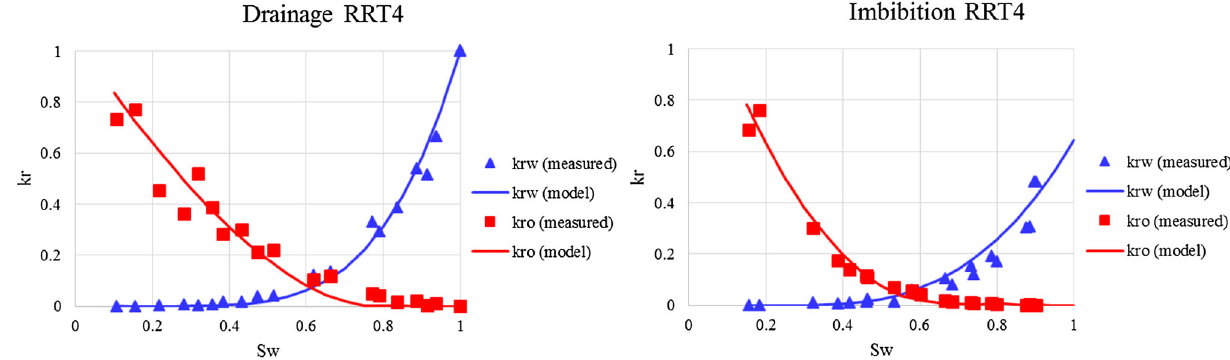
Fig. 23 Drainage and imbibition K r correlation for RRT 4